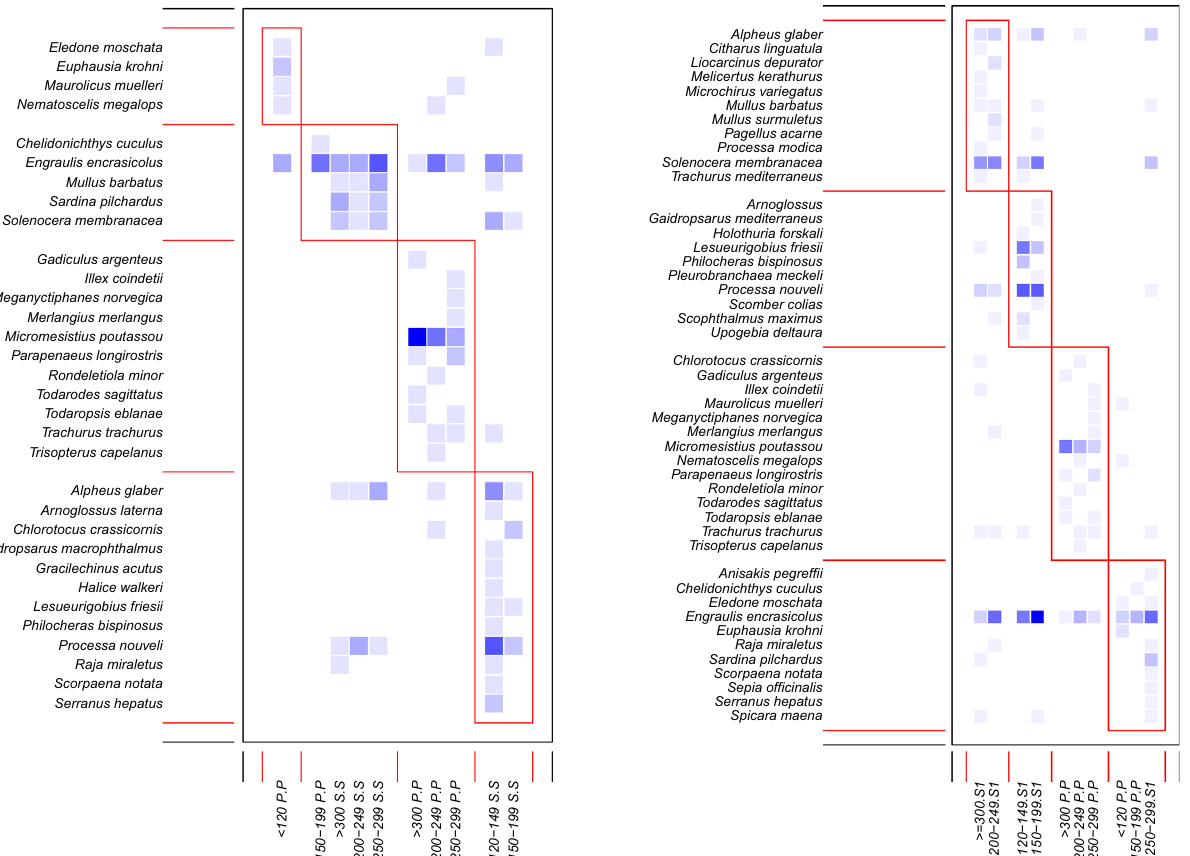
Figure 4. Heat map showing modules (aggregated sets of interacting species) detected in the bipartite weighted graphs by applying Newman’s modularity measure. Shading of matrix entries indicates number of observations (darker shades describe a higher number of observations). On the left modules identified in 2016 samples (inside Pomo, P; shelf outside S), on the right modules identified by using samples collected within the Pomo Pit in 2016 (P) and outside the Pomo Pit in 2014 (depicted as S1, Riccioni et al . , 2018). Modules are identified in red. Analysis performed by using the R package bipartite 75 and R environment 77